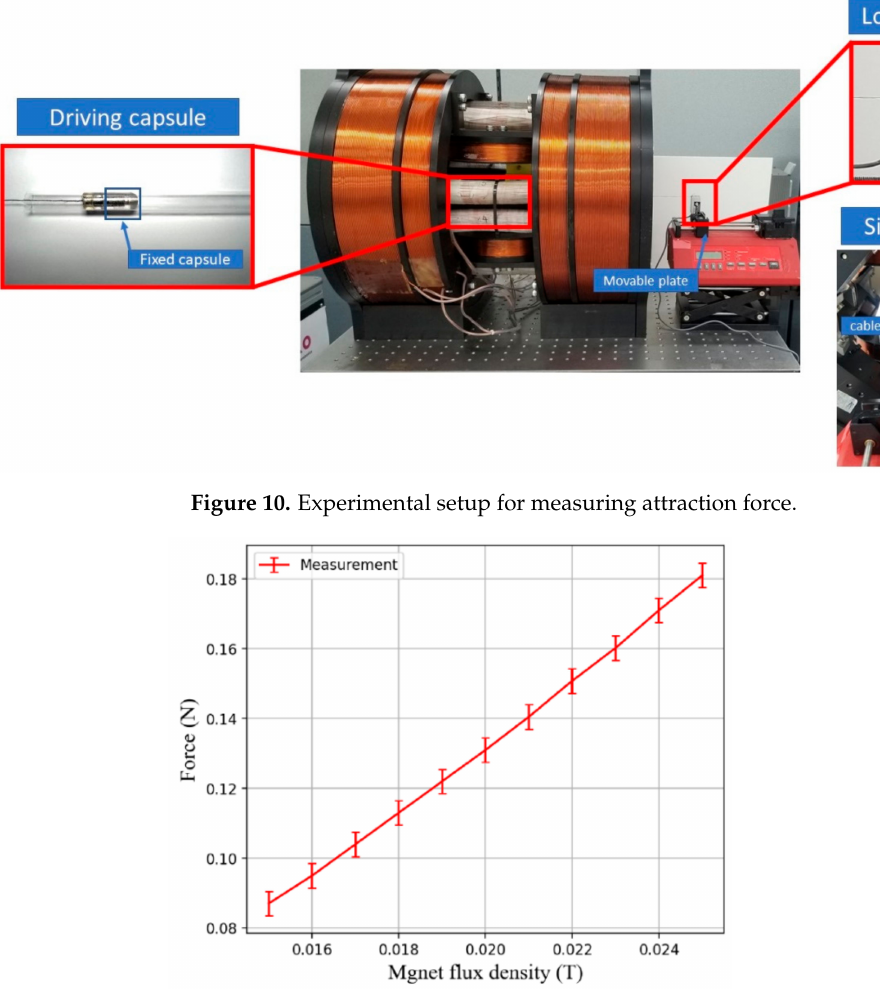
Figure 11. Measured attraction force between the modular